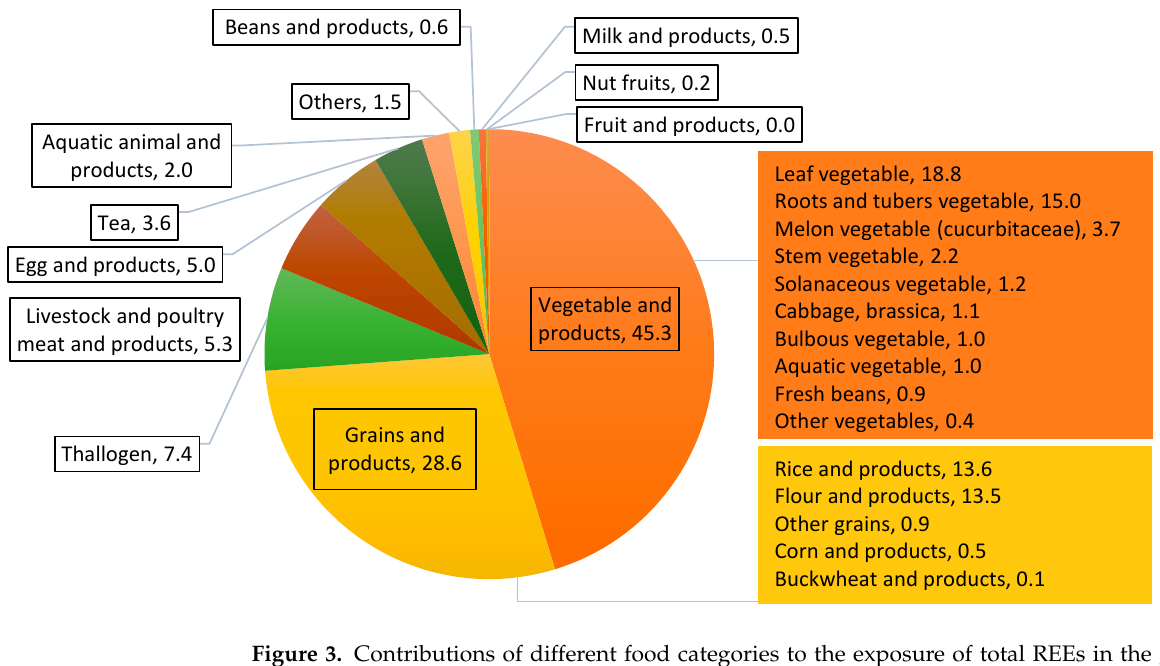
Figure 3. Contributions of different food categories to the exposure of total REEs in the general population (%).